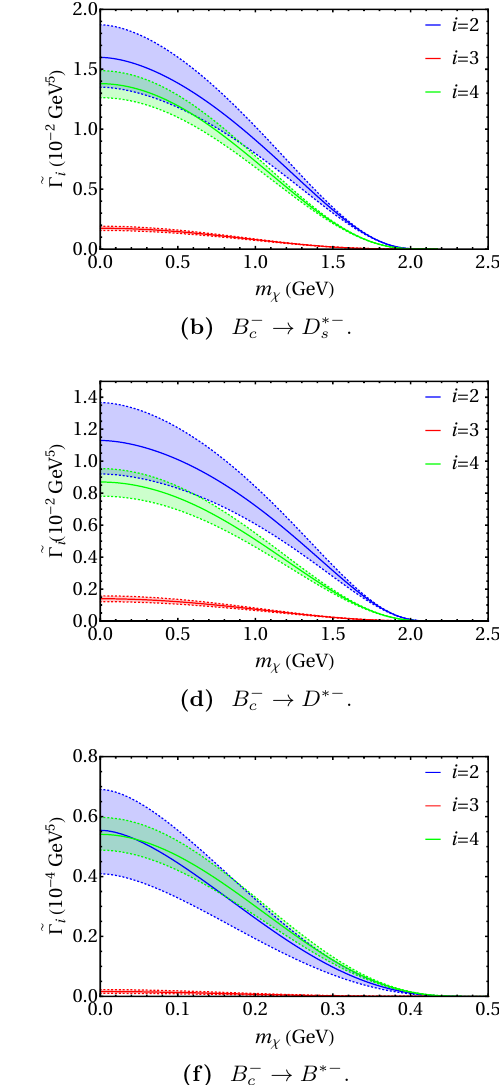
Figure 11. The quantity e (cid:0) represent the errors estimated by varying the parameters in our model by